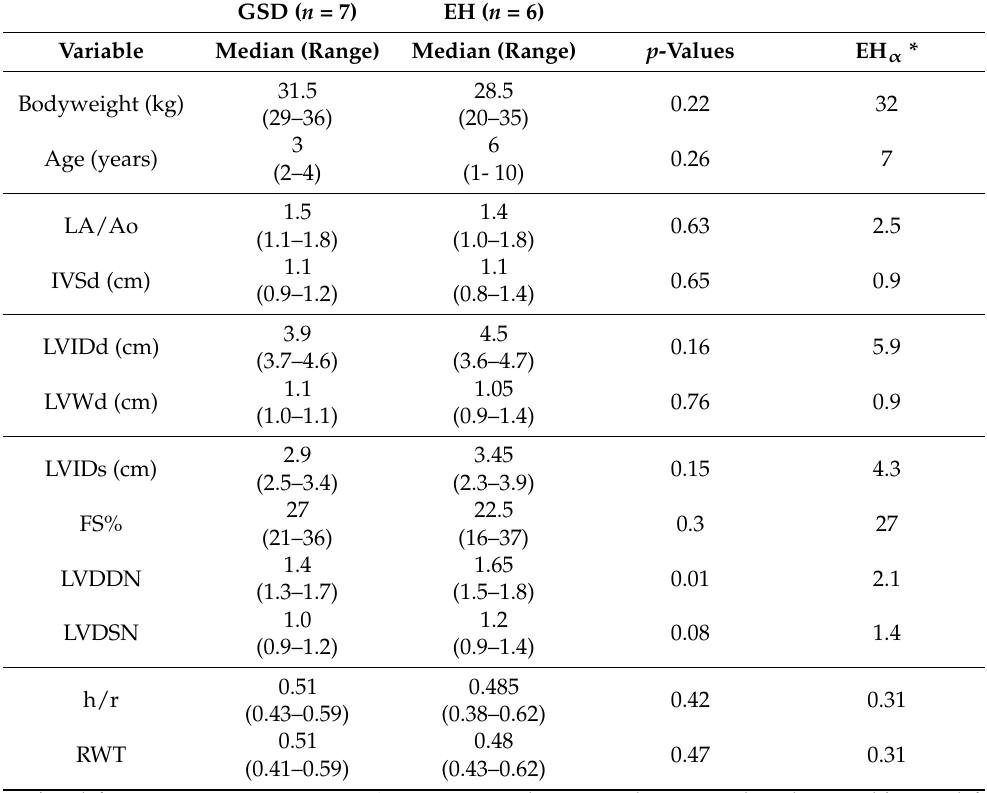
Table 1. Weight, age, and selective echocardiographic parameters in German shepherd dogs (GSDs) and Eurohounds (EHs) at T 0